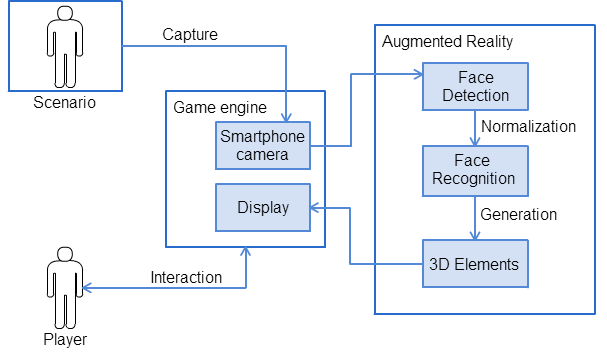
Figure 9: Diagram of the main components of the game.